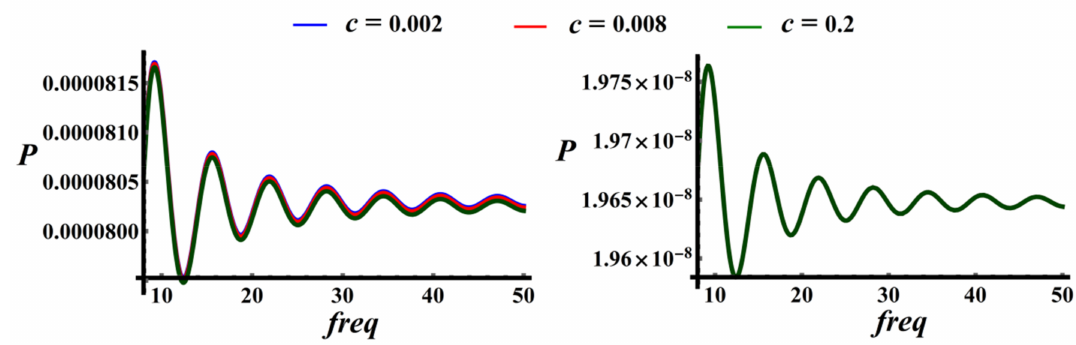
Figure 35. The output power versus excitation frequency with varying the damping